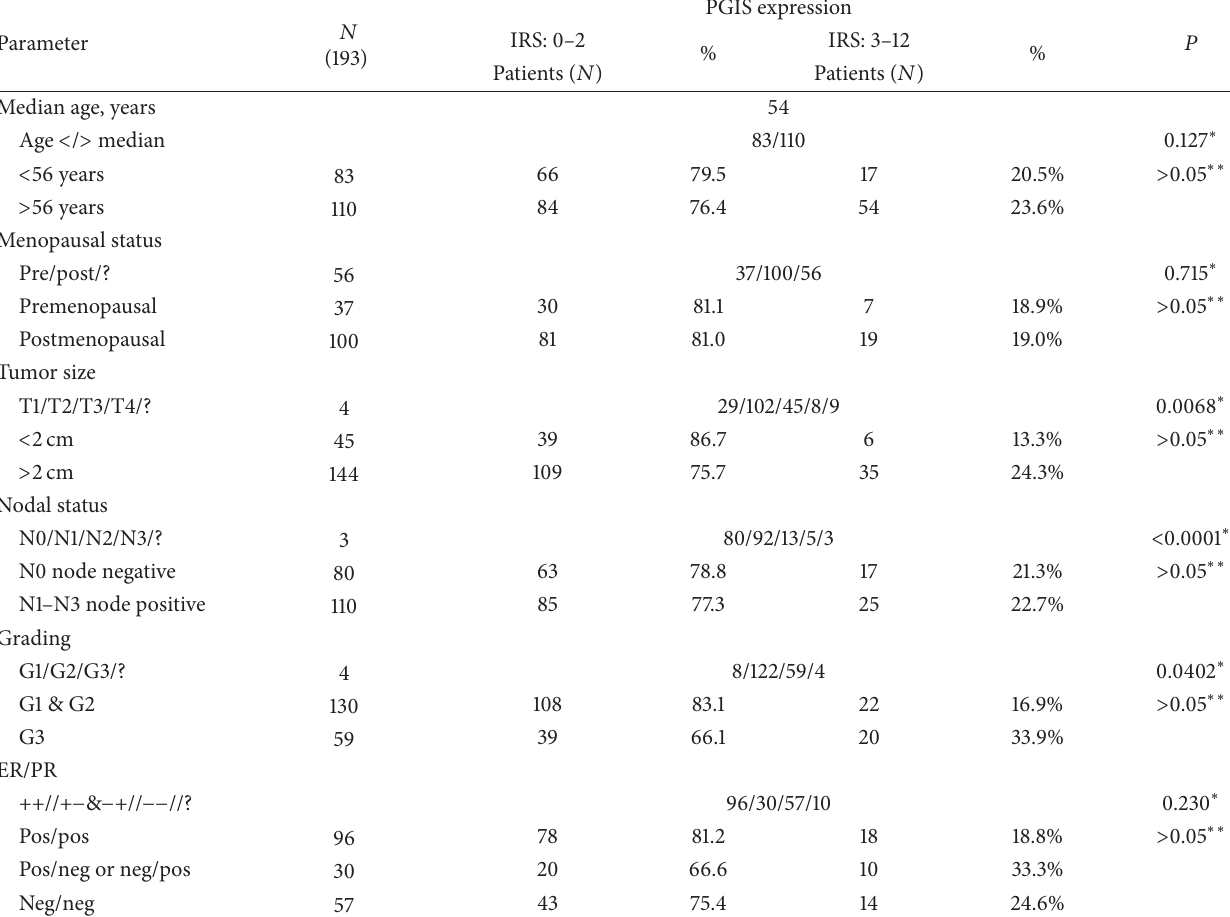
Table 1: Statistics on patients’ clinical data, classical prognostic factors, and PGIS expression ( 𝑛 = 193